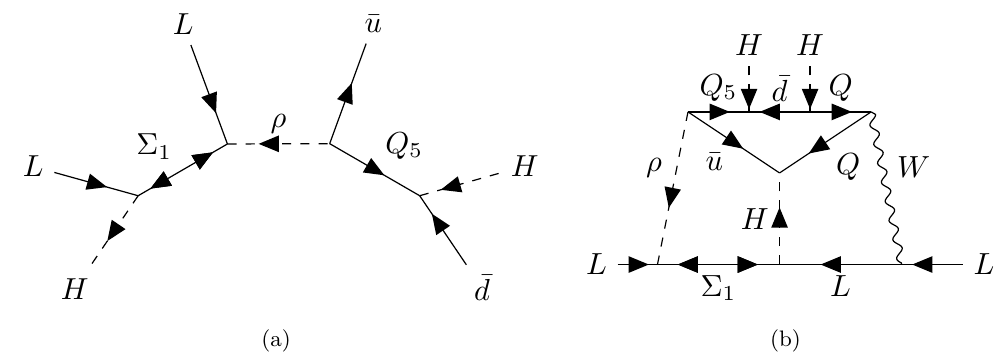
Figure 18. (a) The tree-level completion diagram for the model that generates the single-derivative operators O D 10 ,a,b,c and discussed in the main text. The topology is 2 s 4 f 8 in our classification scheme. This class of topologies is only relevant to single-derivative operators, and contains an arrow-preserving fermion propagator, that of Q 5 in the diagram. The closure of the diagram involves a W -boson loop, similar to that required in figure 17. (b) One of the neutrino-mass diagrams relevant to the model generating O D 10 a,b,c . The diagram generates the Weinberg operator as drawn, but additional diagrams exist with the central H line cut into an H, H † pair that generate O 0 1 instead. These diagrams will only be relevant for exotic masses less than about 2 TeV . Additional three-loop diagrams exist in which the Higgs coming from the Σ 1 LH † interaction loops into any of the other external H fields. The W boson must connect to the Q line, but could end on any other field with non-trivial SU(2) L charge. The topology is cocktail-like [105], and resembles D M 15 in ref.